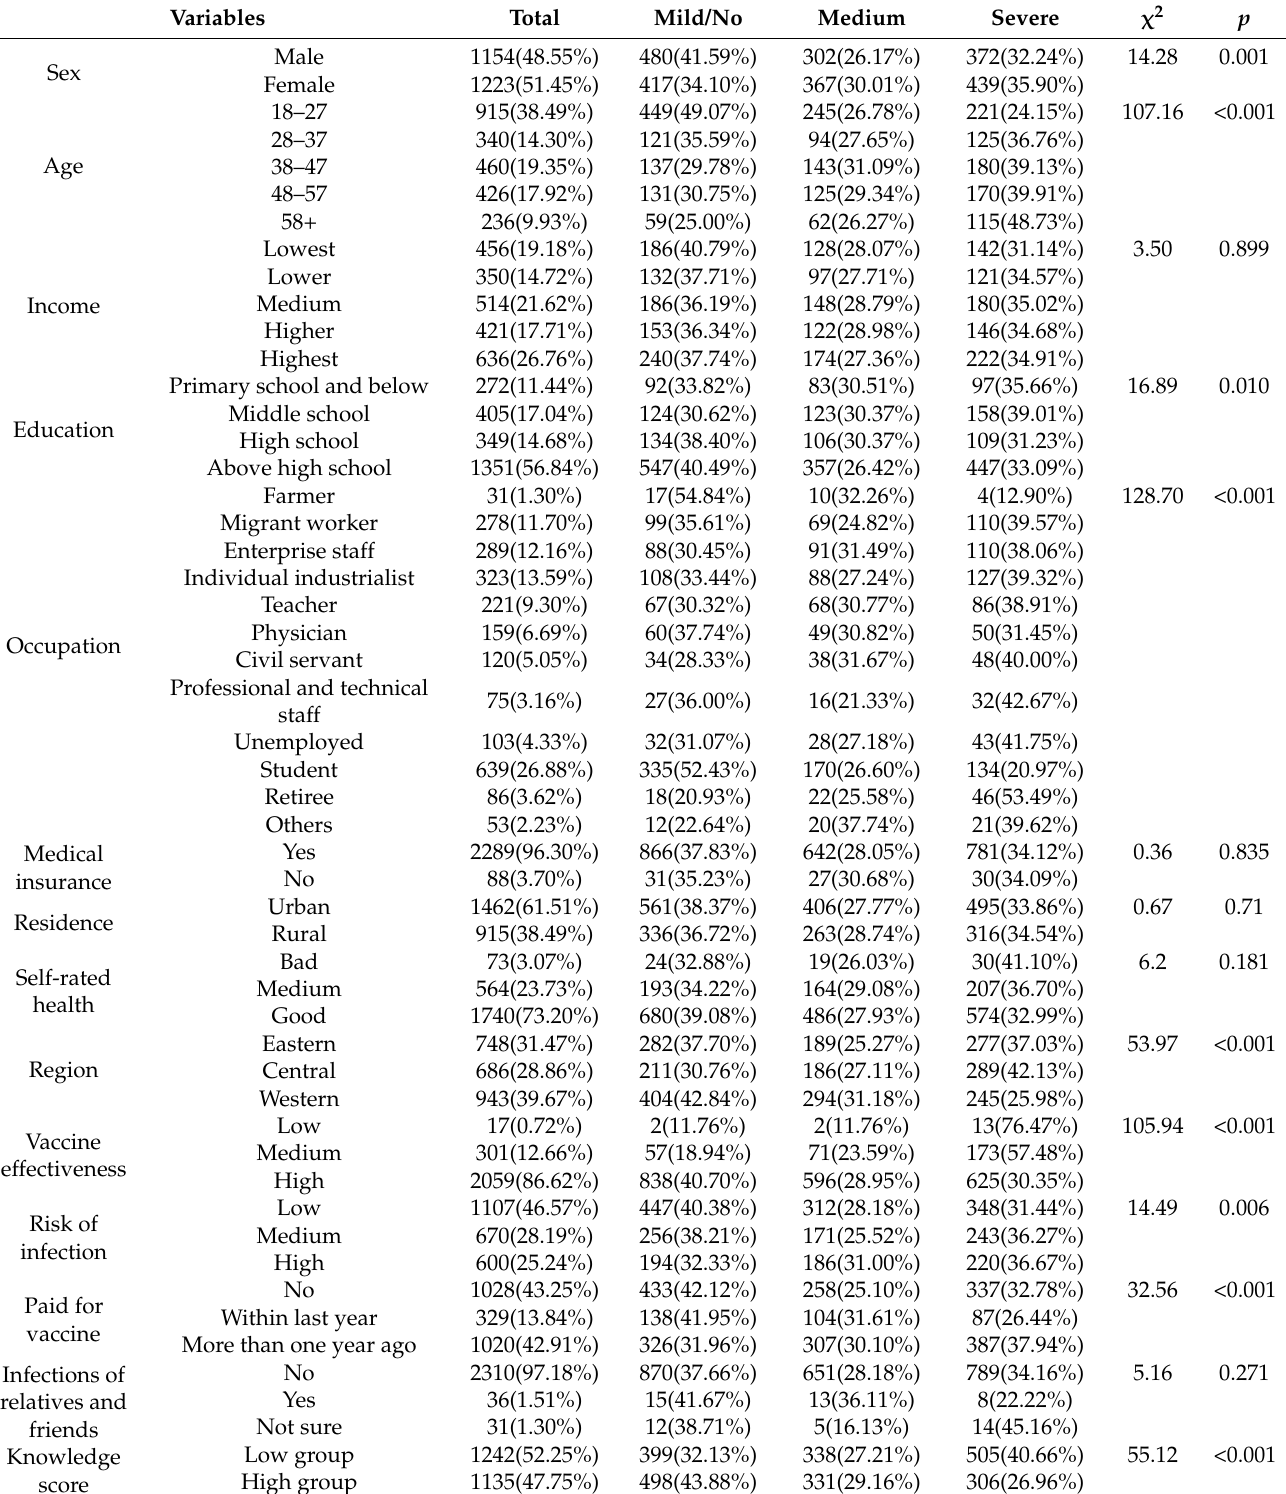
Table 2. Discrimination levels and characteristics of respondents (N